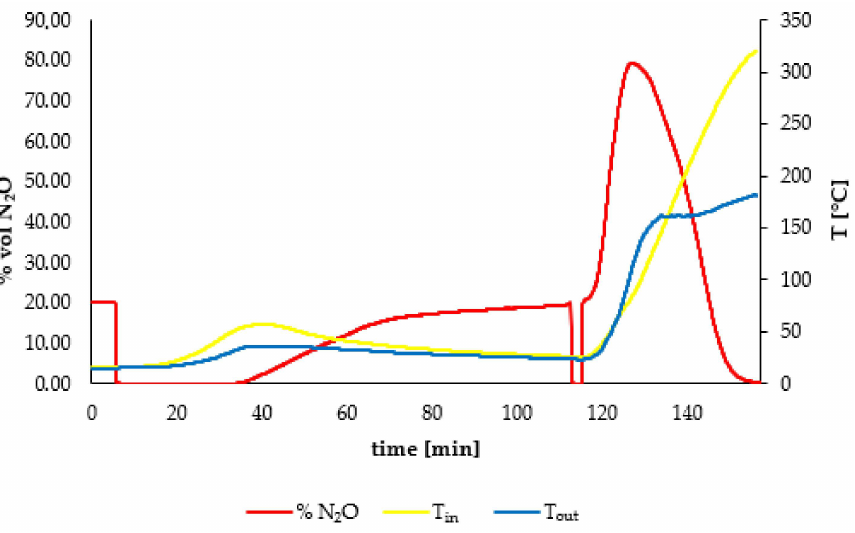
Figure 13. Typical temperature trend for an adsorption–desorption test of N 2 O (dry